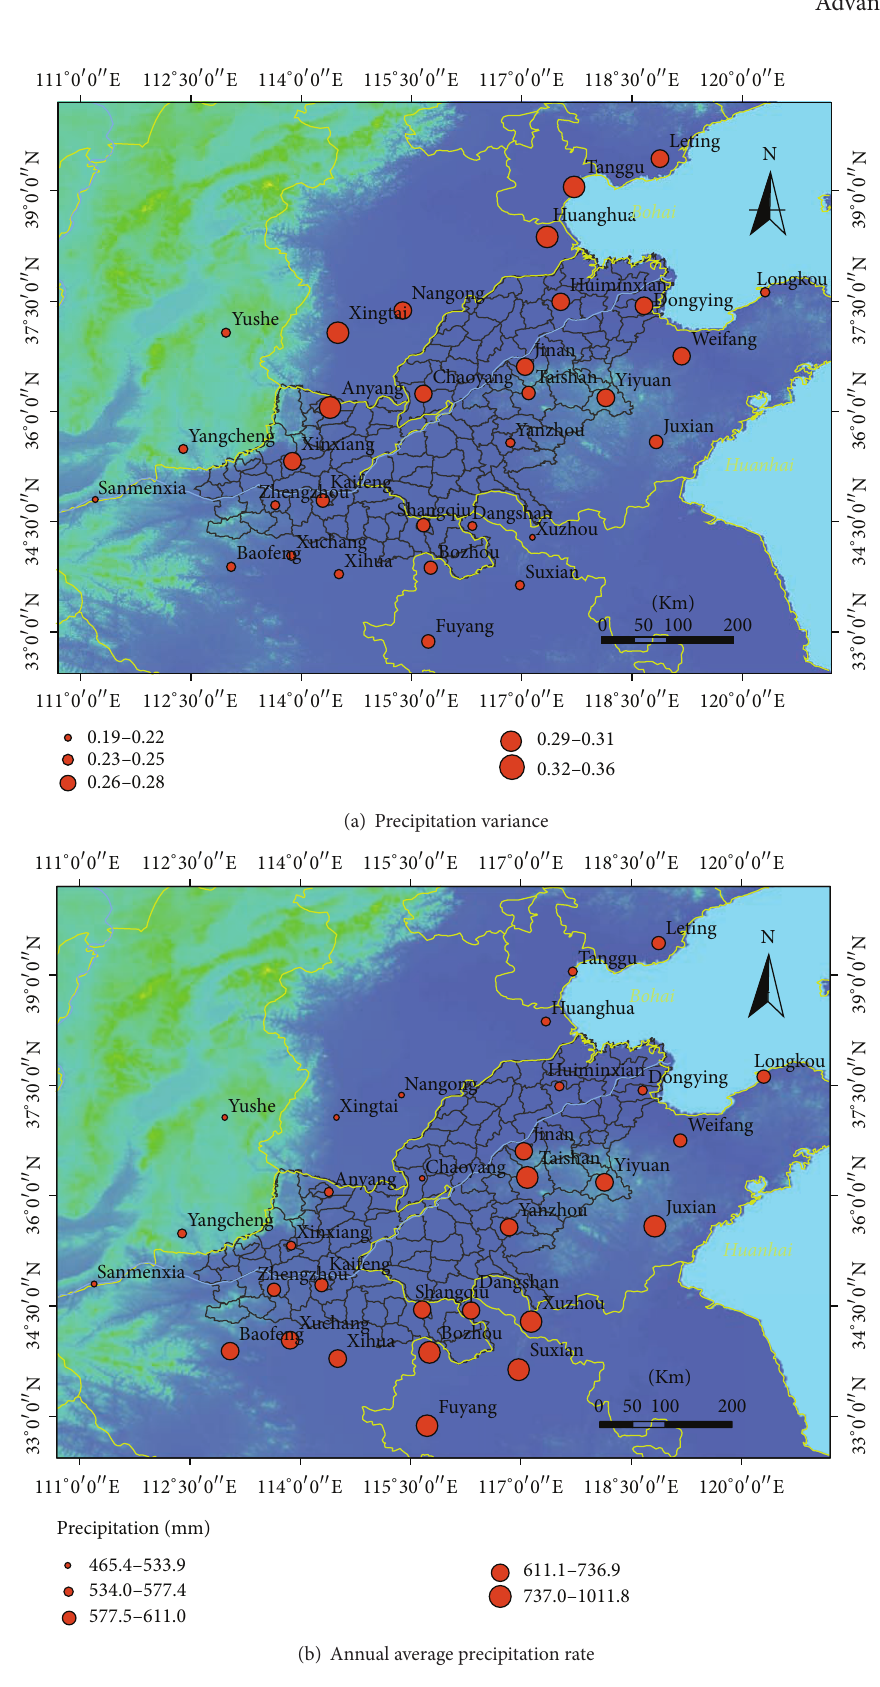
Figure 12: Distribution of annual precipitation variation and average annual precipitation rate in the Lower Yellow River Region from 1960 to